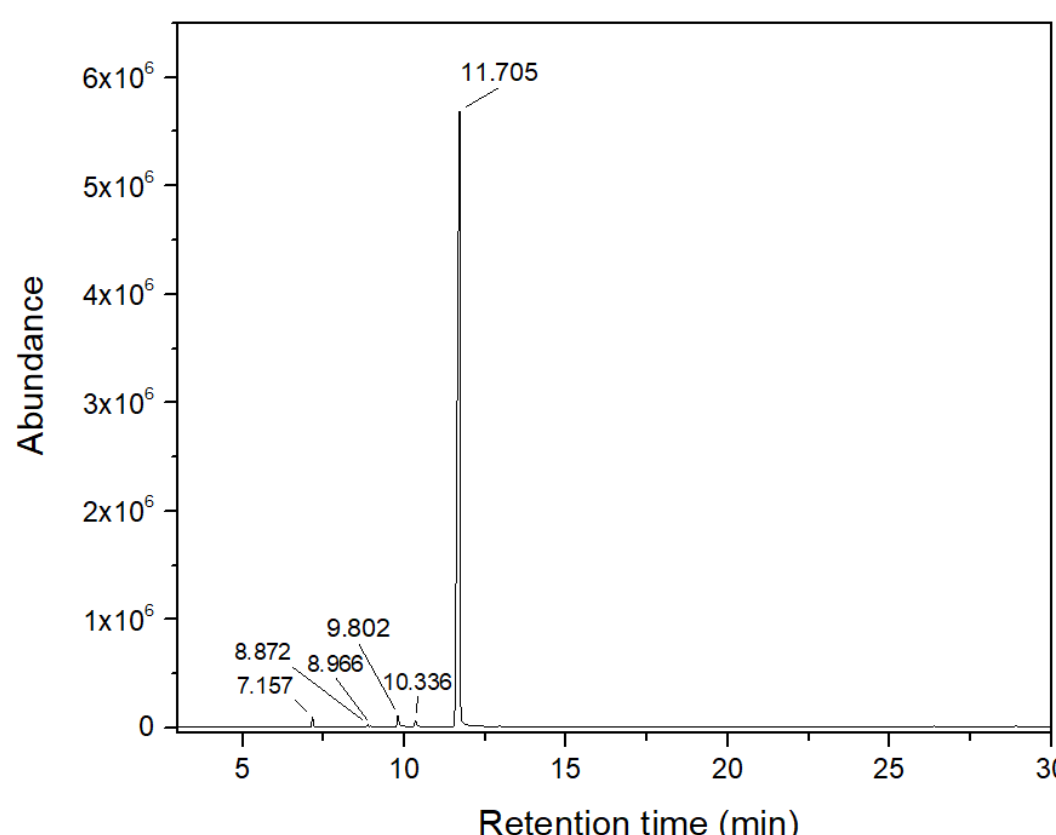
Figure 7. Spectral chromatography of GC-MS.